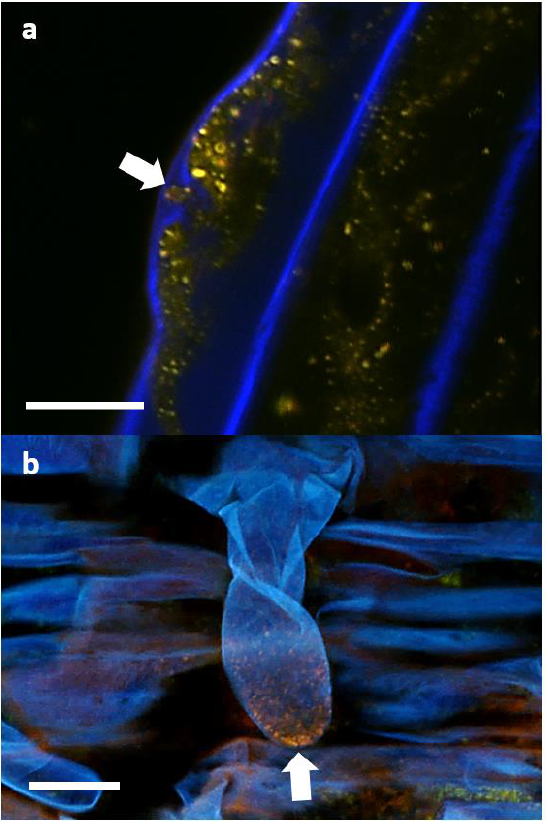
Figure 13. P3AW: mCherry gathers at the root hair tips of inoculated clover roots. P3AW: mCherry L-forms can be seen in ( a ) a root hair primordial and ( b ) a fully formed root hair. The arrows point to the root hair tip. Scale bar = 10 μm.